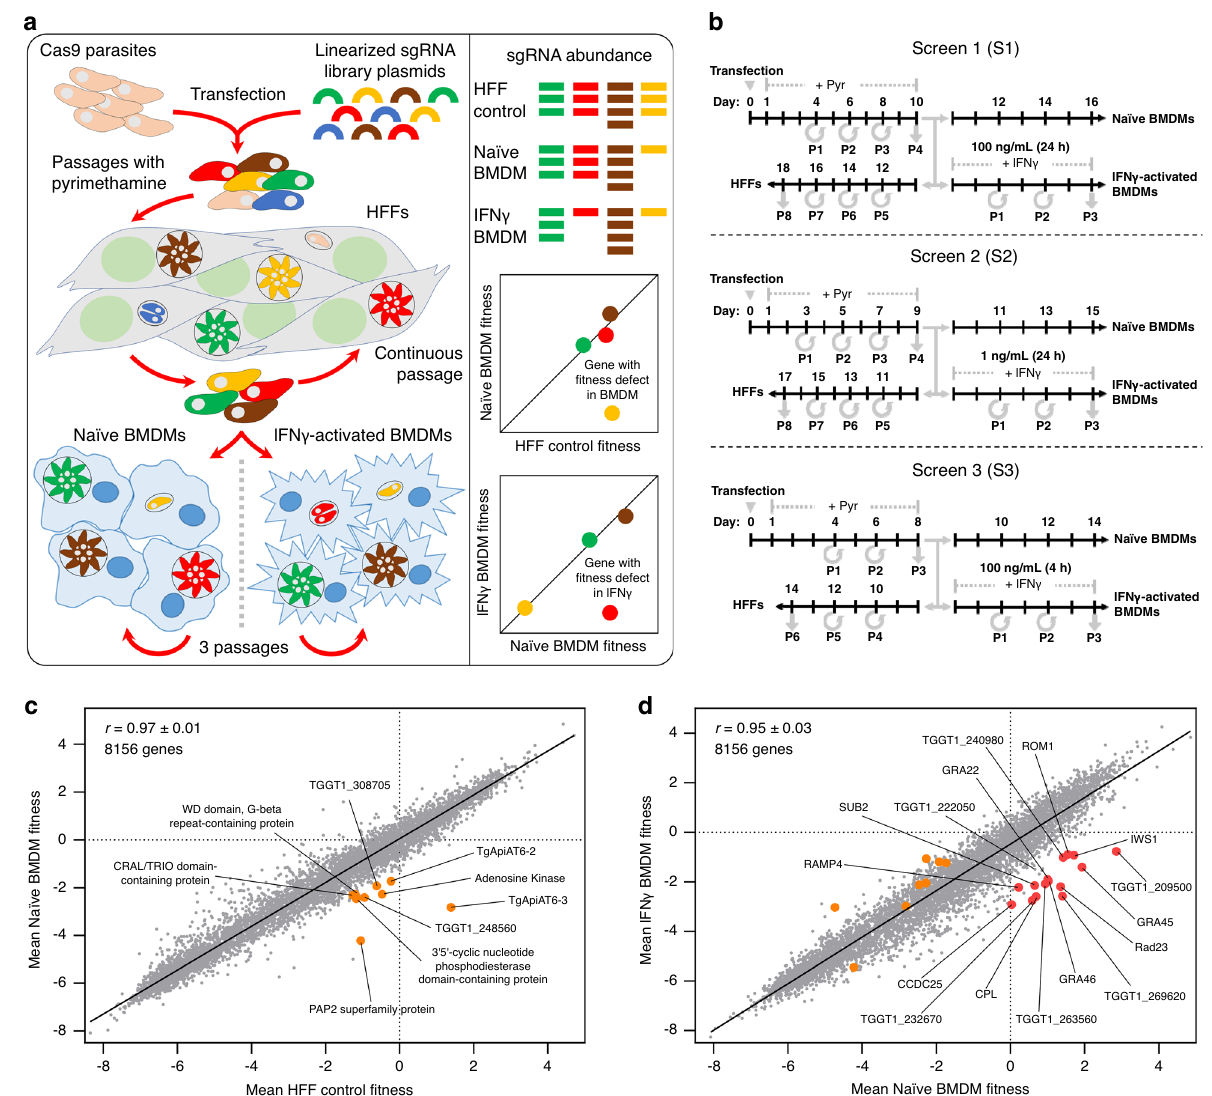
Fig. 1 Toxoplasma gondii genome-wide loss-of-function screen in naïve or IFN γ -activated murine bone-marrow-derived macrophages. a Screening work fl ow. At least 5 × 10 8 Cas9-expressing RH parasites were transfected with linearized plasmids containing 10 sgRNAs against every Toxoplasma gene. Transfected parasites were passaged in HFFs under pyrimethamine selection to remove non-transfected parasites and parasites that integrated plasmids with sgRNAs targeting parasite genes important for fi tness in HFFs. Subsequently, the pool of mutant parasites was either continuously passaged in HFFs or passaged for three rounds in murine BMDMs that were left unstimulated or prestimulated with IFN γ . The sgRNA abundance at different passages, determined by illumina sequencing, was used for calculating fi tness scores and identifying genes that confer fi tness in naïve or IFN γ -activated BMDMs. b Timeline for the generation of mutant populations and subsequent selection in the presence or absence of murine IFN γ . Times at which parasites were passaged (P) are indicated. c Correlation between mean parasite gene fi tness scores in Naïve BMDMs and HFF control. Orange dots indicate nine high- con fi dence candidate genes that confer fi tness in naïve BMDMs compared to HFFs (Table 1). d Correlation between mean parasite gene fi tness scores in IFN γ -activated and Naïve BMDMs. Red dots indicate 16 high-con fi dence IFN γ fi tness-conferring candidate genes in murine BMDMs and orange dots the nine high-con fi dence genes conferring fi tness in naïve BMDMs compared to HFFs (Table